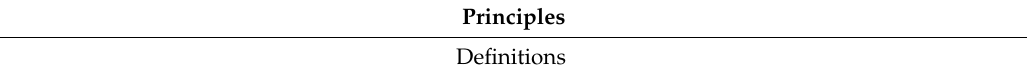
Table 2. Ensemble Kalman